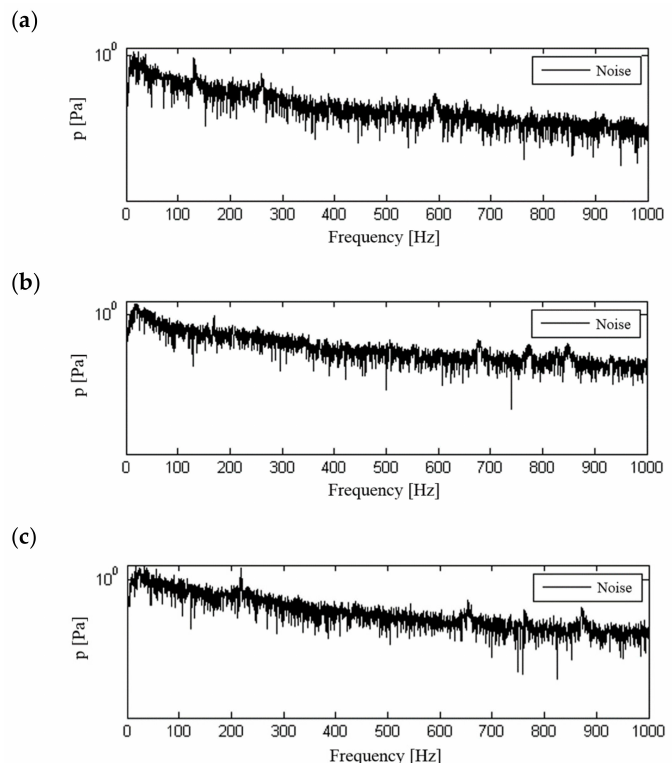
Figure 13. Frequency analysis of sound pressure in the helmet: ( a ) speed 50 km / h, ( b ) speed 70 km / h, ( c ) speed 90 km /